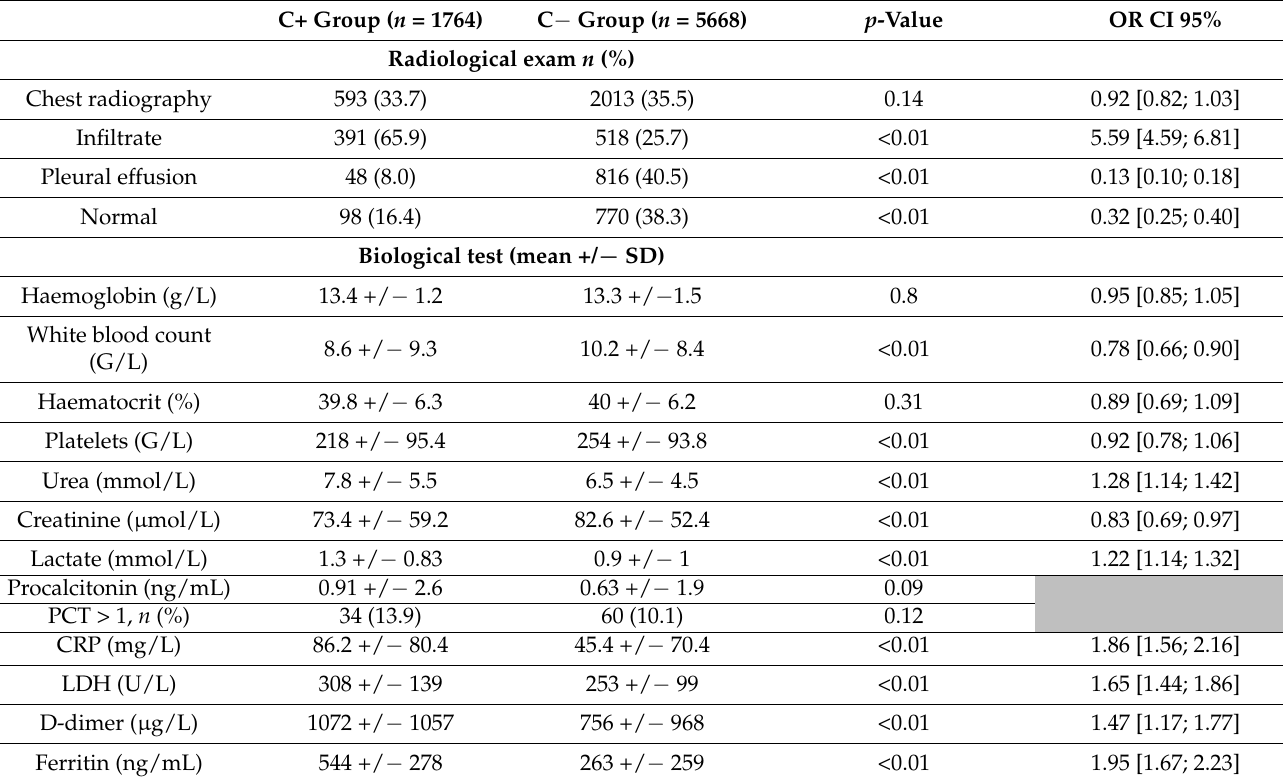
Table 5. Additional tests performed at the admission in emergency department.